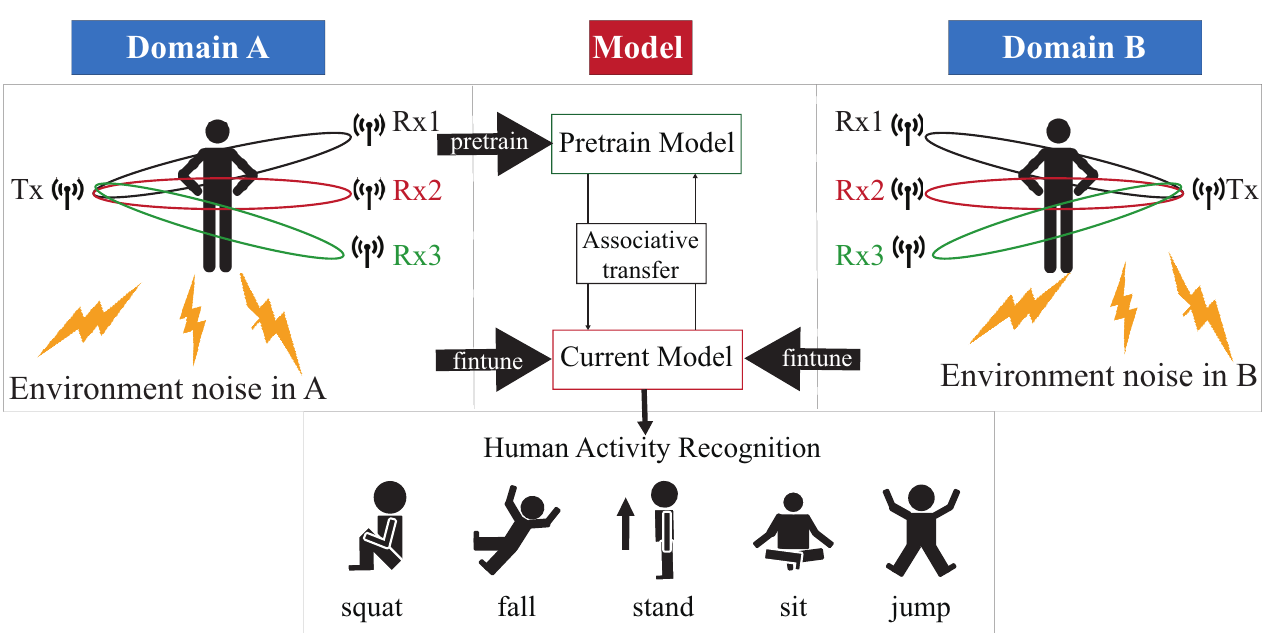
Figure 1. Our proposed DADA-AD